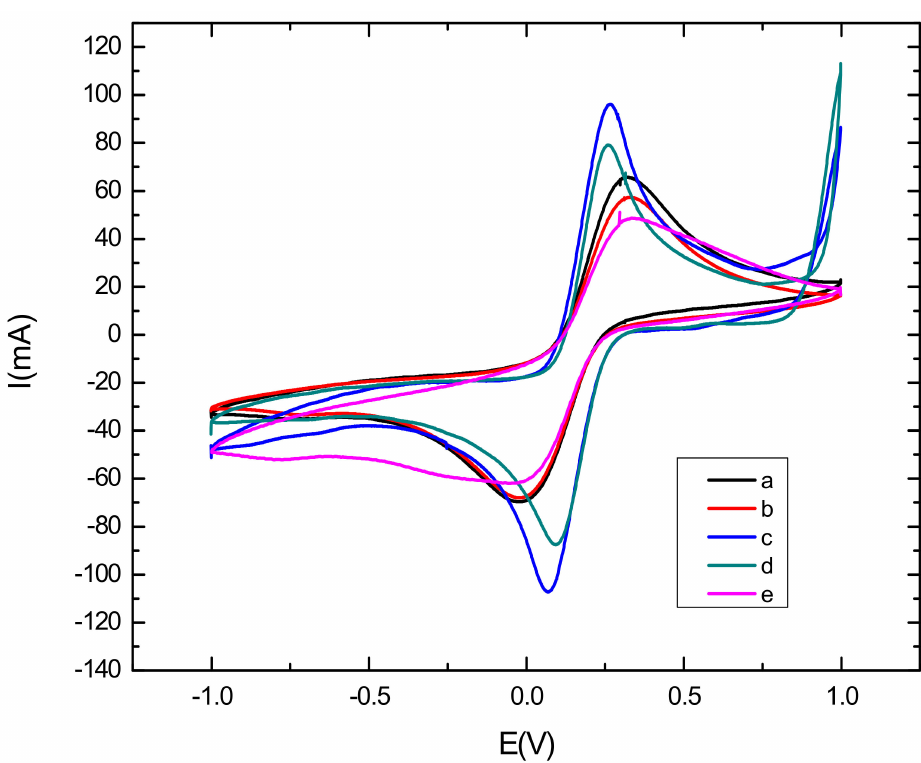
Figure 3. Cyclic voltammograms in the presence of K 3 [Fe(CN) 6 ]/K 4 [Fe(CN) 6 ] for: bare electrode (curve a), Cs-CNTs/GCE (curve b), AuNPs/Cs-CNTs/GCE (curve c), Apta/AuNPs/Cs-CNTS/GCE (curve d), Cd 2+ /Apta/AuNPs/Cs-CNTS/GCE (curve e). Potential was scanned from 1 V to − 1 V with a scan rate of 50 mV s − 1